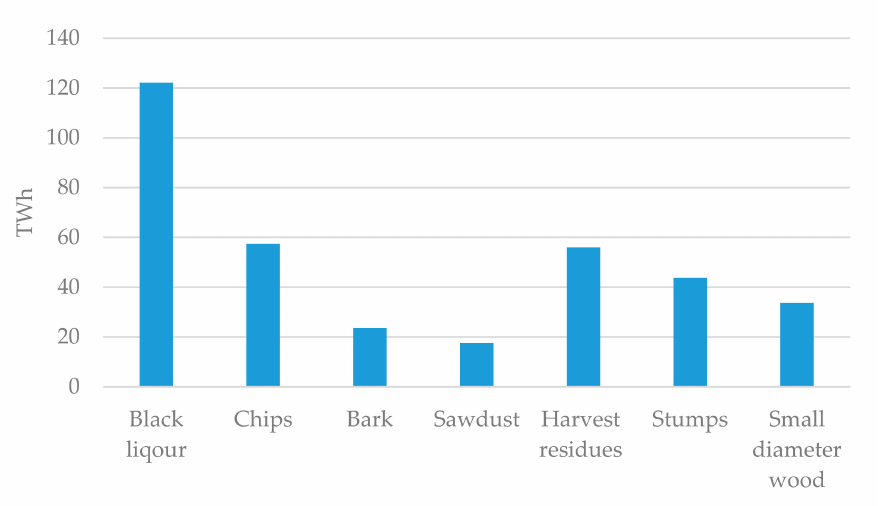
Figure 1. Nordic forest biomass potential split on different biomass types except roundwood (TWh/year). Sources: Pöyry and Nordic Energy Research [33].